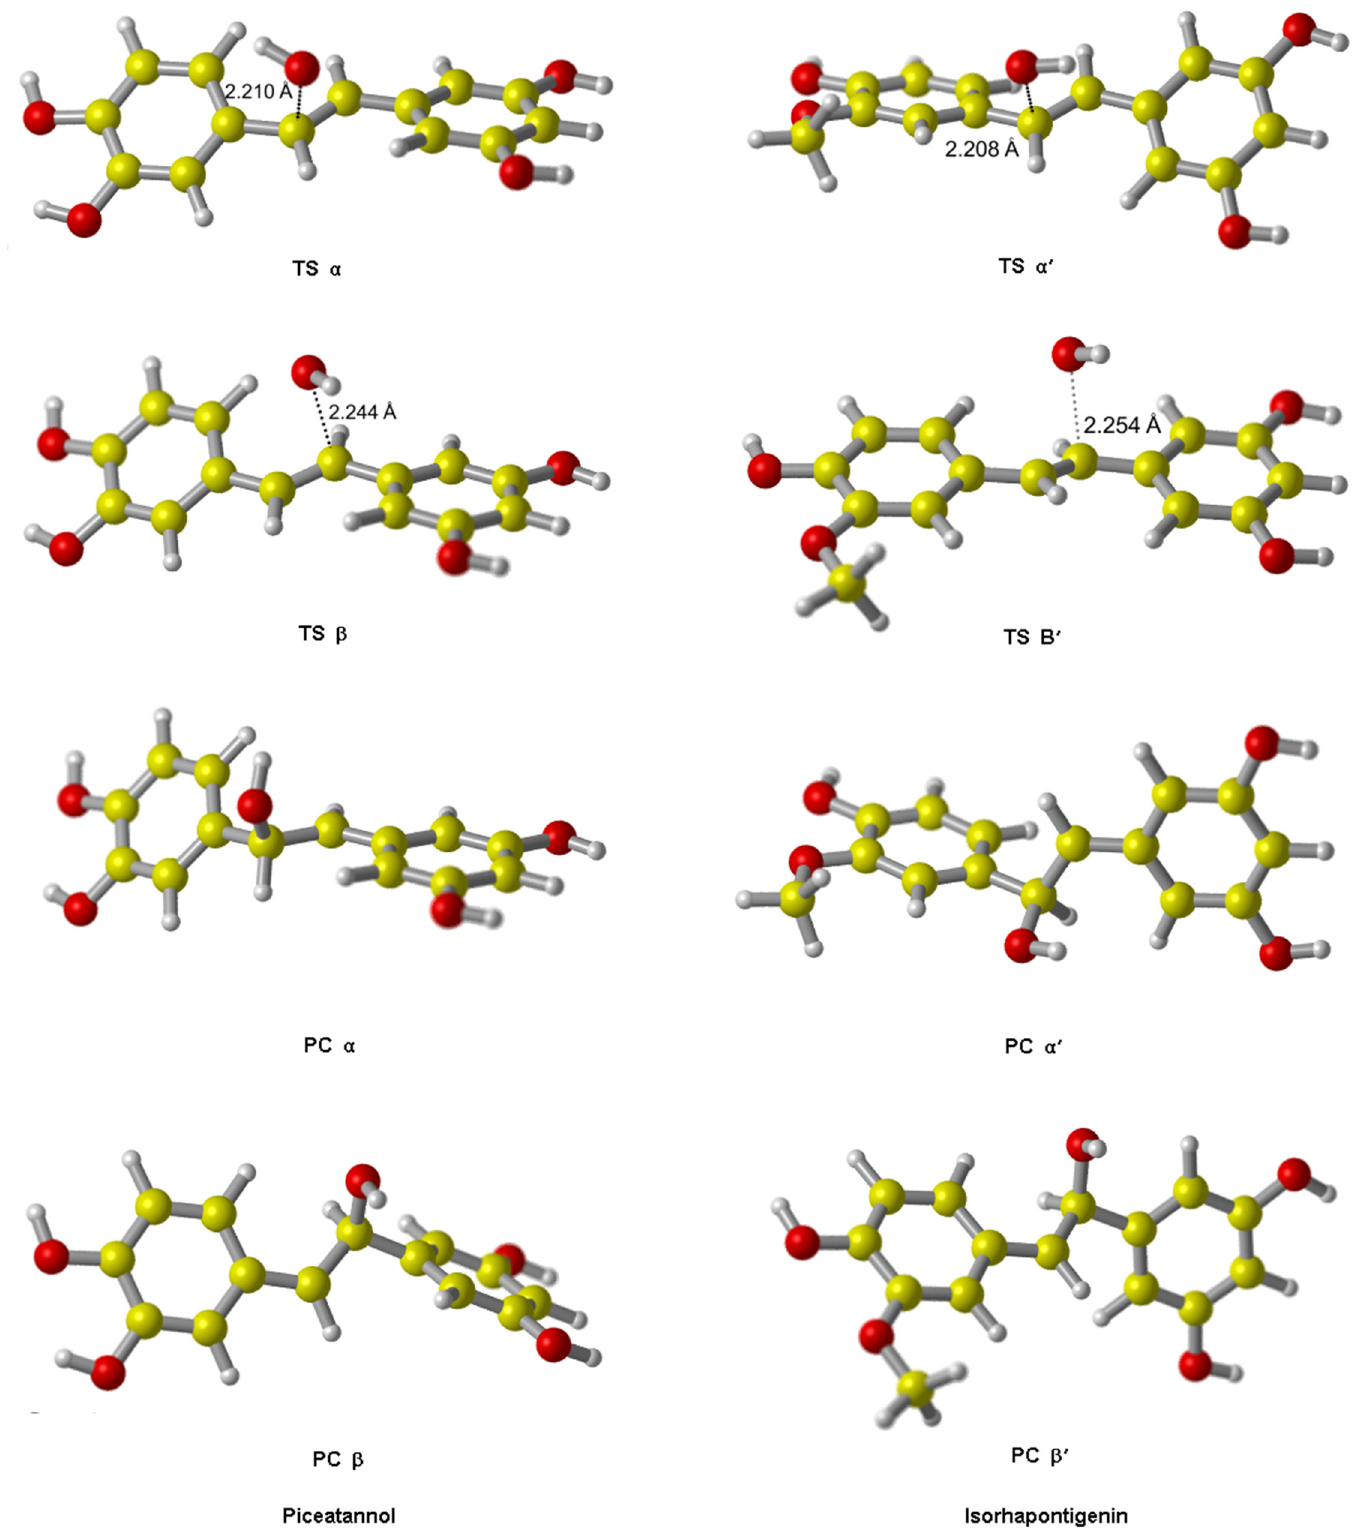
Fig 6. The transition states and product complexes of PIC and ISO from RAF reaction initiated by (cid:129) OH. All TS have only one imaginary frequency, and in their vibrational mode, (cid:129) OH moves in a direction which is perpendicular to that of the carbon atom. The H-atom attached to that carbon atom folds back slightly to accommodate the incoming of (cid:129)